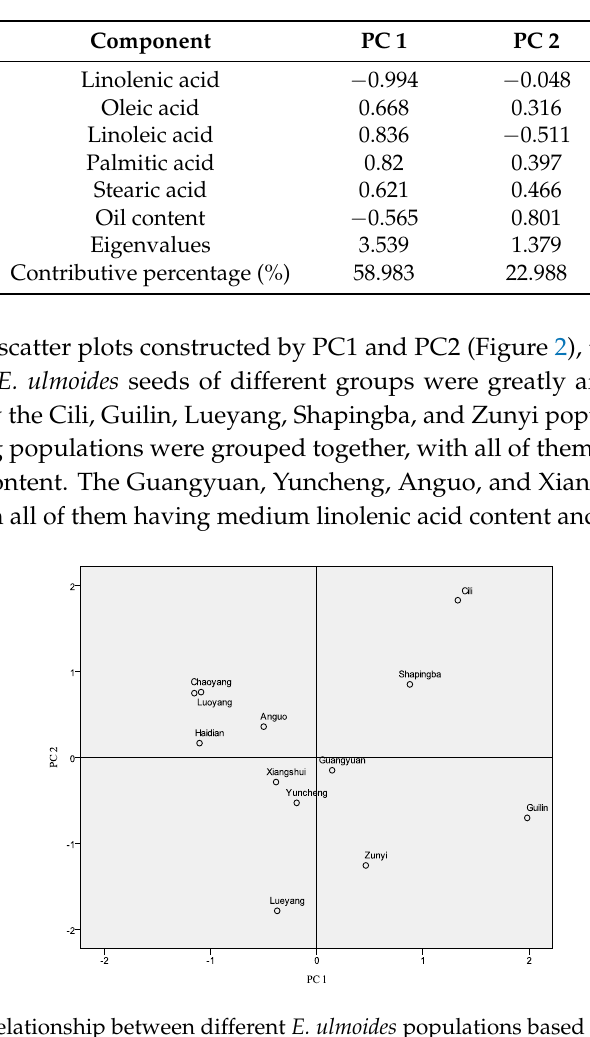
Table 4. The principal component analysis (PCA) of oil content and fatty acids among different populations.